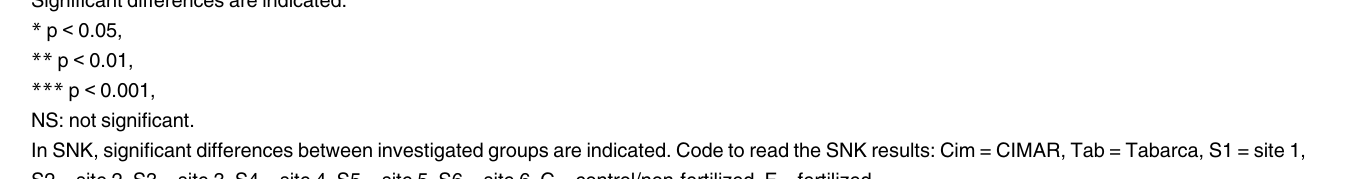
Treatment” (p = 0.4434.). For this ANOVA design, we performed a “post-hoc power analysis” [40] to test the statistical power. Power analyses for factors, “Location”, “Treatment” and the interaction “Location x Treatment” set for a medium size effect (0.25) and α = 0.05, found a power (1- β error probability) = 0.3019. For a medium or moderate size effect (0.35), the power (1- β error probability) = 0.522. This last value is at least suggestive of a correct decision when accepting our null hypothesis, which in our study is that herbivory by S . salpa was not higher in the fertilized plots compared to the non-fertilized plots.